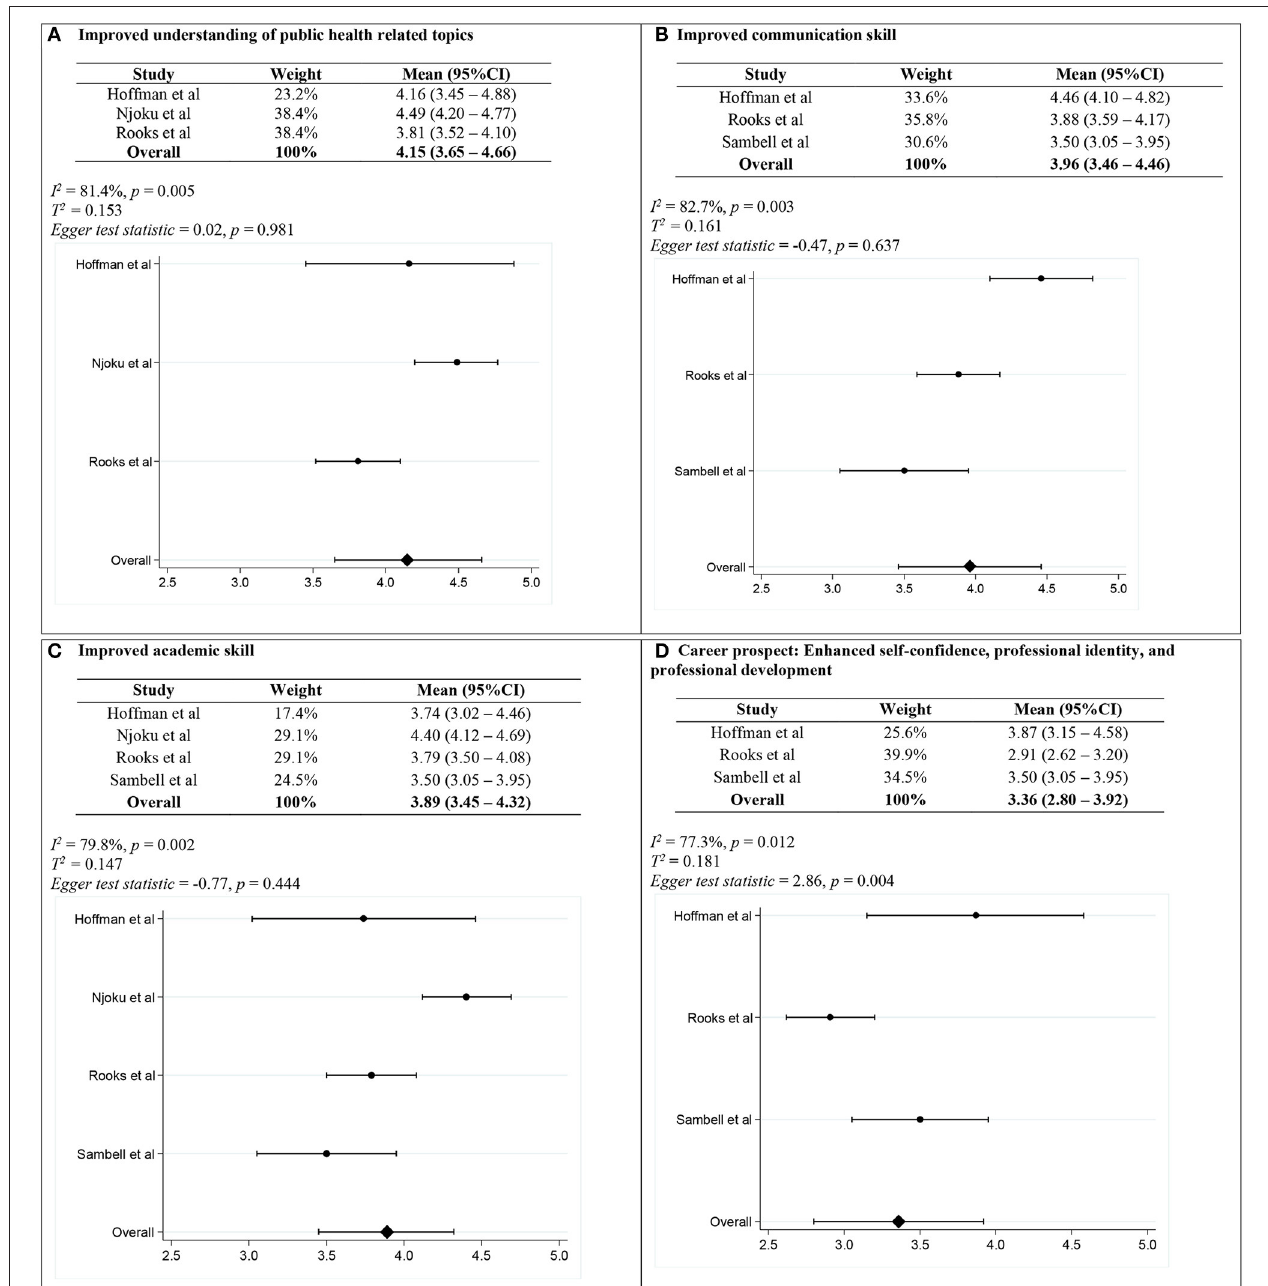
FIGURE 2 | Forest plots illustrating the pooled mean value for (A) understanding of public health related topics, (B) communication skill, (C) academic skill, and (D) career